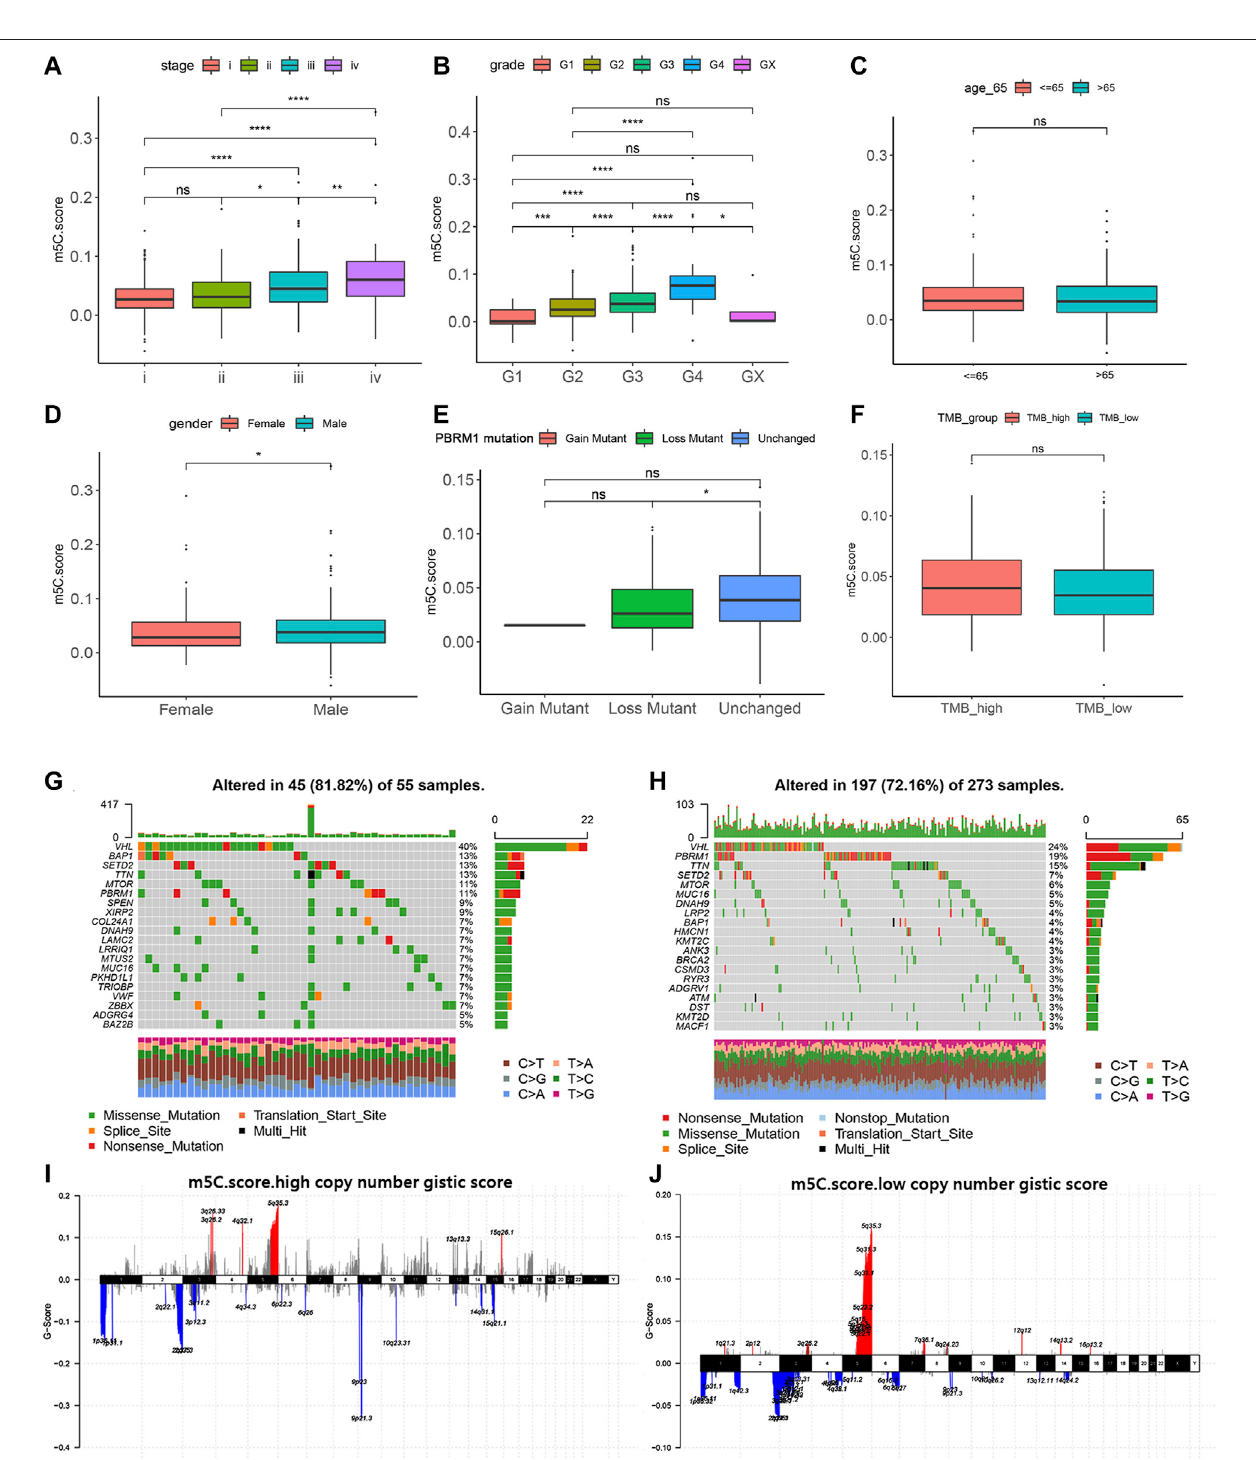
FIGURE 7 | Relation of m 5 C modi fi cation with clinicopathological features and tumor somatic mutation. (A – F) Associations of m 5 C score with stage, grade, age, gender, PBRM1 mutation status, and TMB in TCGA cohort. (G – H) Landscapes of somatic variants of high and low m 5 C score groups in TCGA cohort. (I – J) Copy number variants of high and low m 5 C score groups in TCGA cohort.